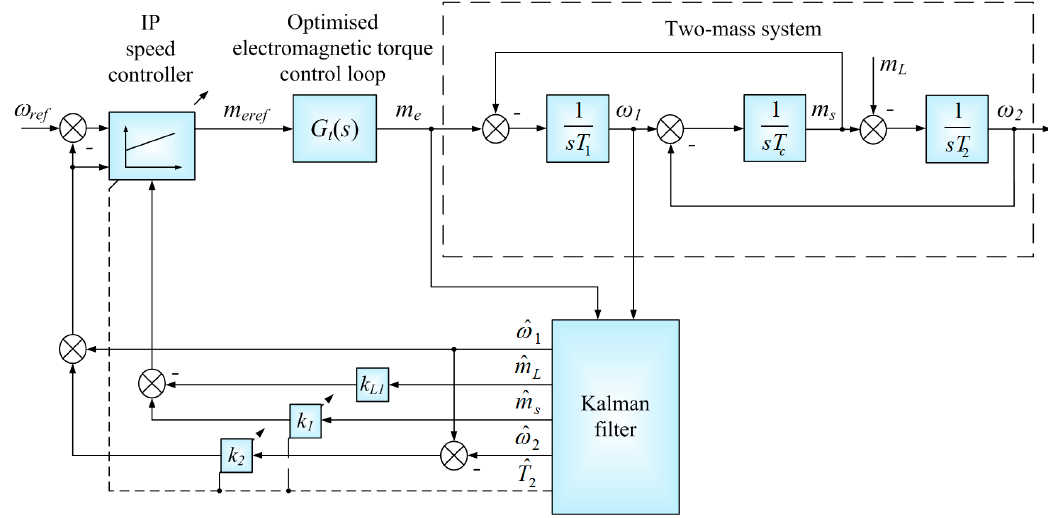
Figure 1. The schematic diagram of considered control structure with adaptation mechanism.